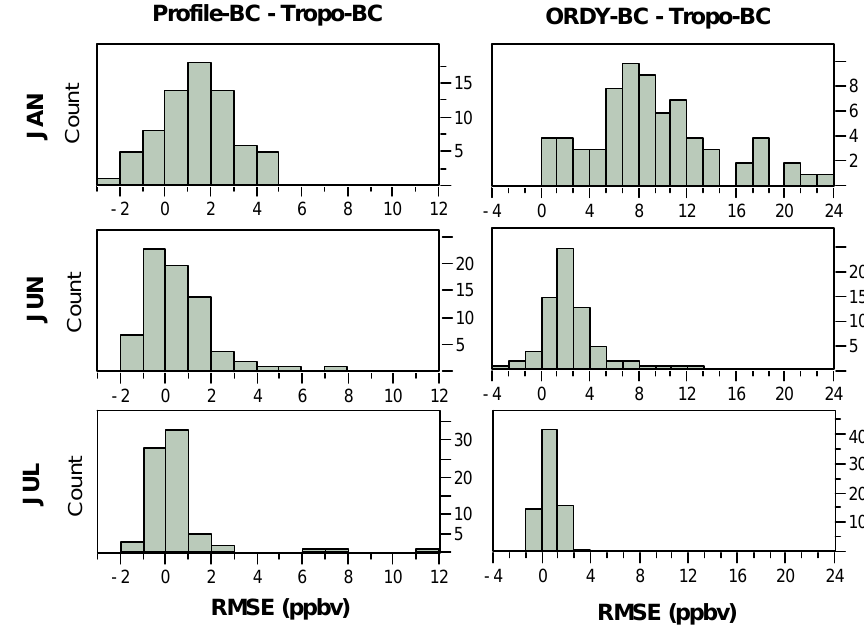
Fig. 11. Summary of the RMSE distributions for the differences among these three Fig. 13. Summary of the RMSE distributions for the differences among these three scenarios for each CASTNET scenarios for each CASTNET sites.